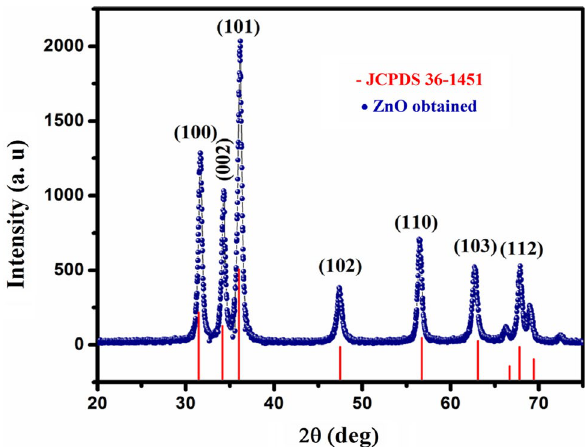
Fig. 3 The X-ray diffraction of ZnO nanoparticles prepared by hydrothermal synthesis. Reproduced from (Abdulkhair et al. 2021) with permission from Elsevier. The peaks at 31.71°, 34.38°, 36.30°, 47.52°, 56.56°, 62.91°, and 67.93° correspond to the (10 0), (0 02), (101), (102), (110), (103), and (112) planes of zinc oxide nanopar- ticles, respectively. The diffractions are consistent with the wurtzite hexagonal structure of zinc oxide nanoparticles (JCPDS